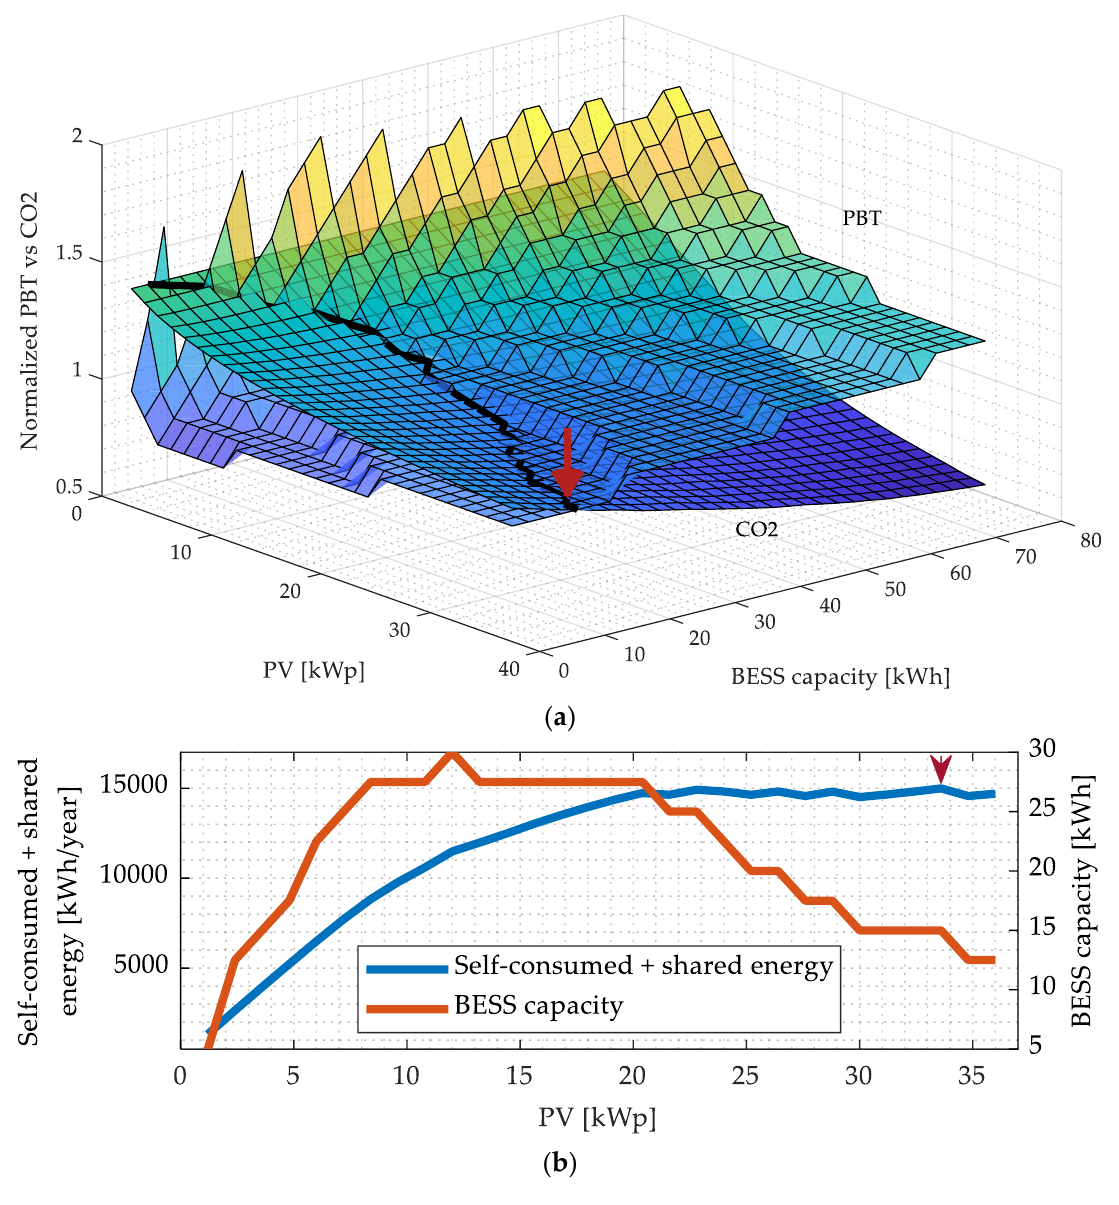
Figure 8. ( a ) Normalized PBT vs. total CO2 emissions for Scenario 6. The black line represents the intersection of the two surfaces; ( b ) sum of total self-consumed energy and shared energy values and BESS capacity for the trade-off points considered for Scenario 6.